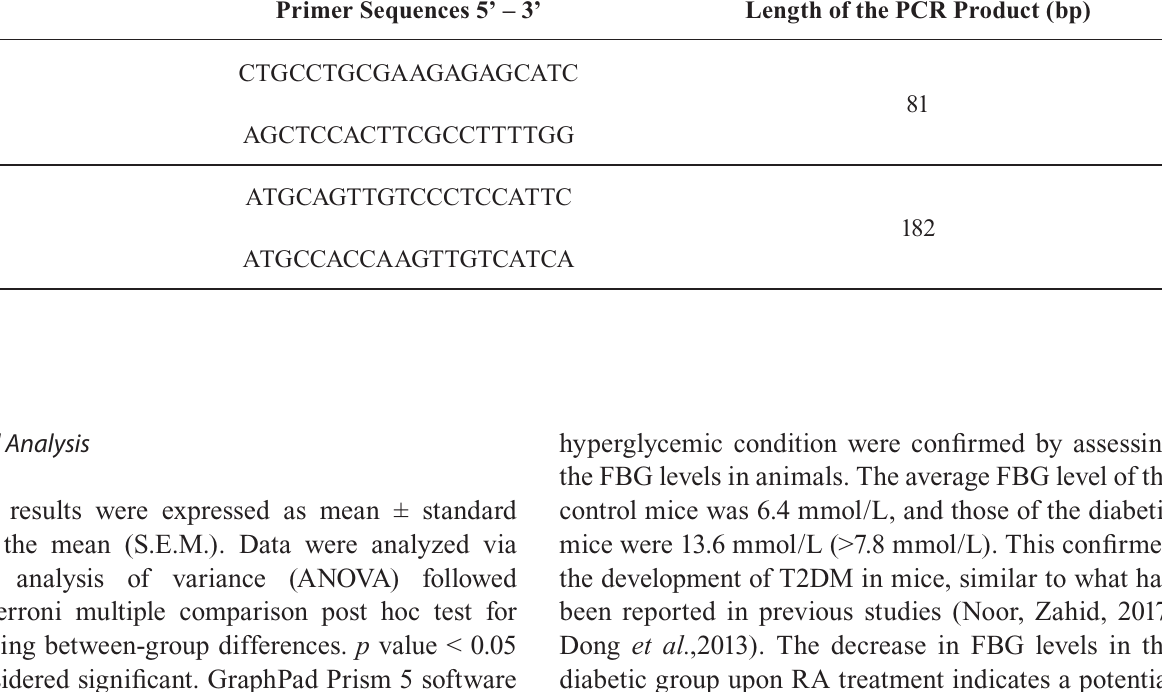
TABLE I - F orward and reverse primer sequences used for the expression analysis of b -Actin, NeuN, Ki67 and DCX